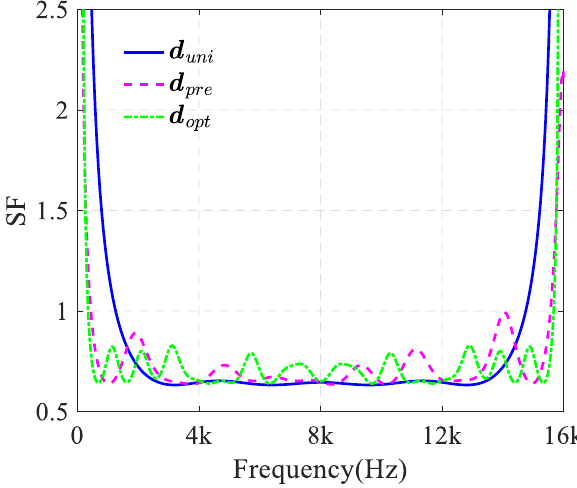
Figure 2. (Color online) Comparisons of singularity factors determined by the uniform microphone array (blue), the previous five non-uniform microphone array [15] and the optimal microphone array (green).